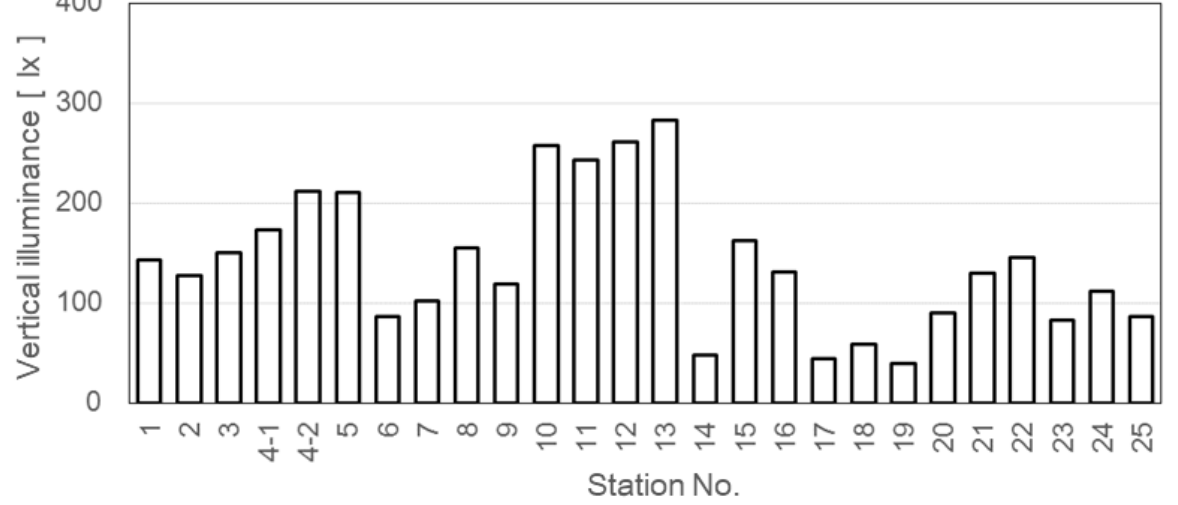
Figure 5. Measurement results of the vertical illuminance of the platforms.